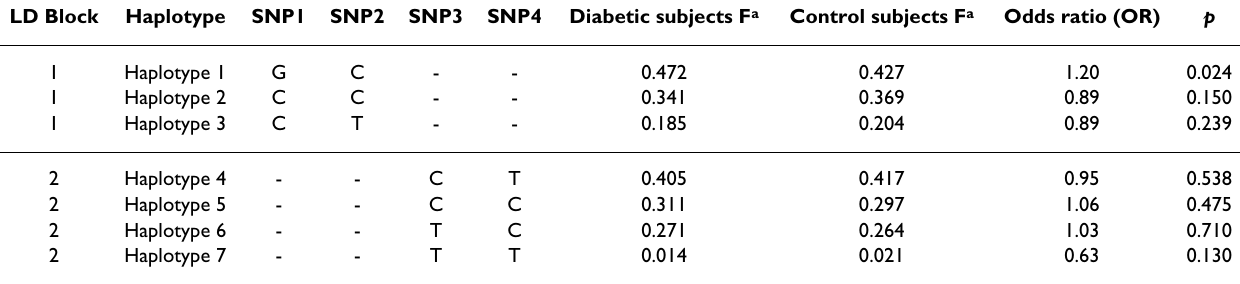
Table 4: Association of PCK1 haplotypes with type 2 diabetes among UK-resident South Asians LD